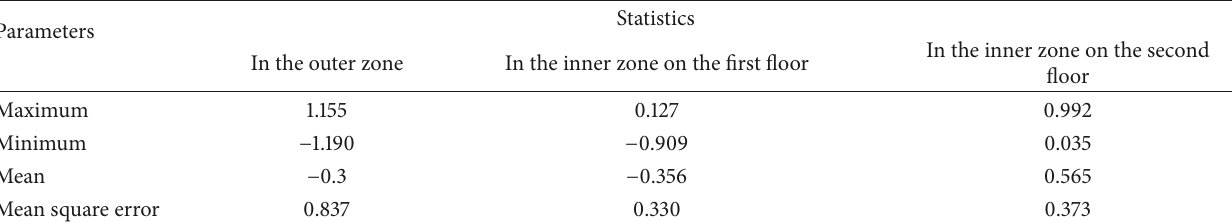
Table 2: Statistics of PMV in the inner and outer